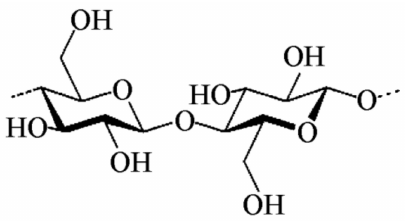
Figure 3. Schematic representation of a cellulose macromolecule.